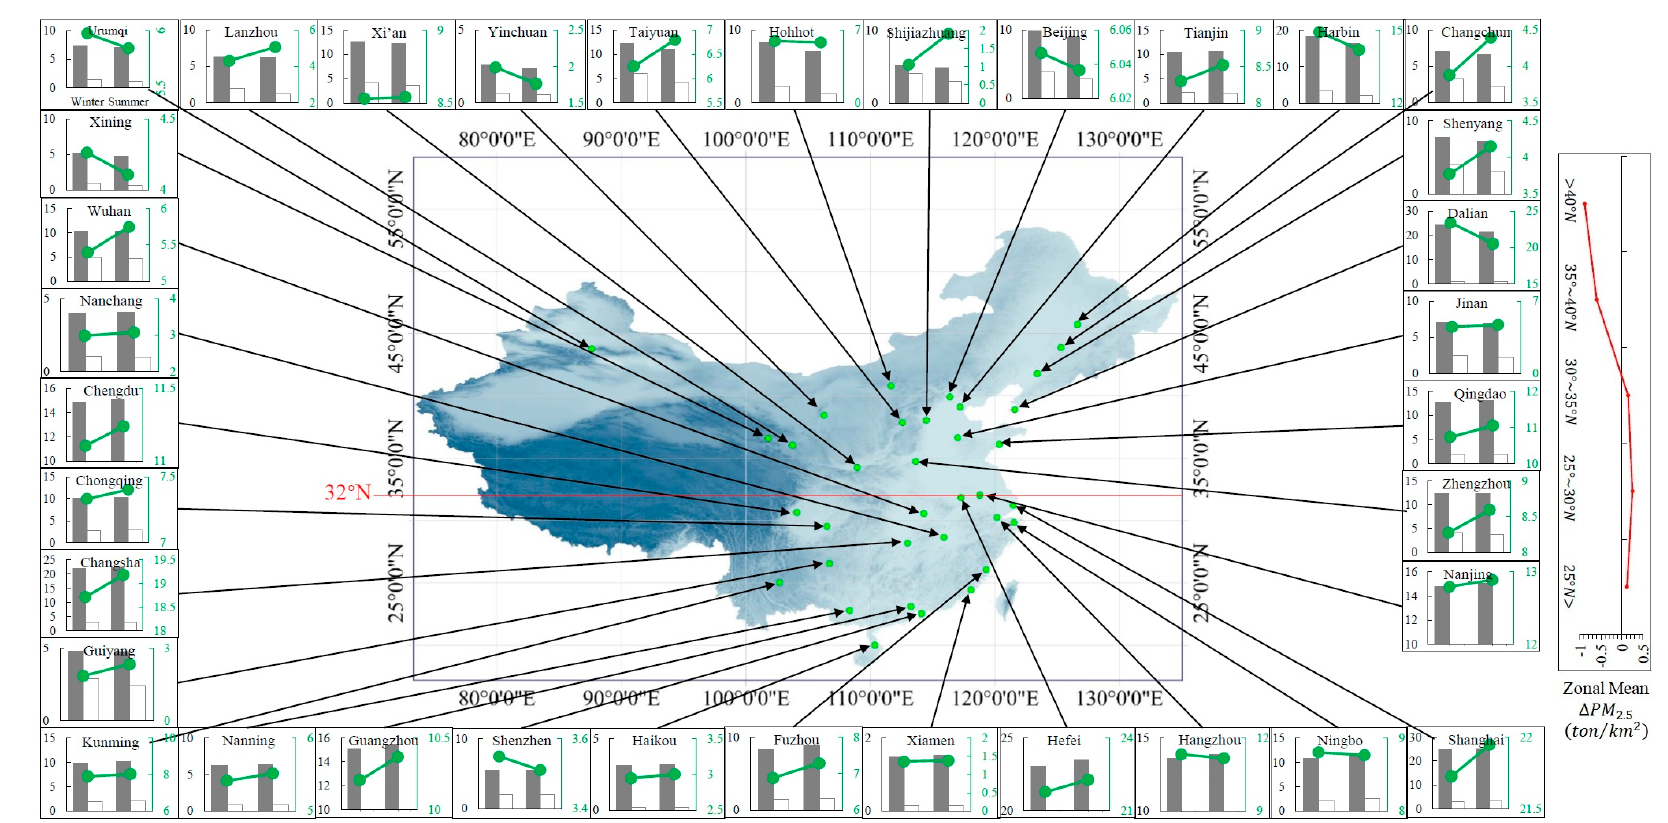
Figure 8. Spatial distribution of mean PM 2.5 emissions (unit: ton / km 2 ) in the urban (filled bars) and rural (unfilled bars) areas of each city in summer and winter, and PM 2.5 di ff erences (green dots, unit: ton / km 2 ) between the urban and rural areas of each city in summer and winter. The ∆ PM 2.5 in right panel is the urban PM 2.5 di ff erences between summer and winter. Data are from 2010 to 2014.